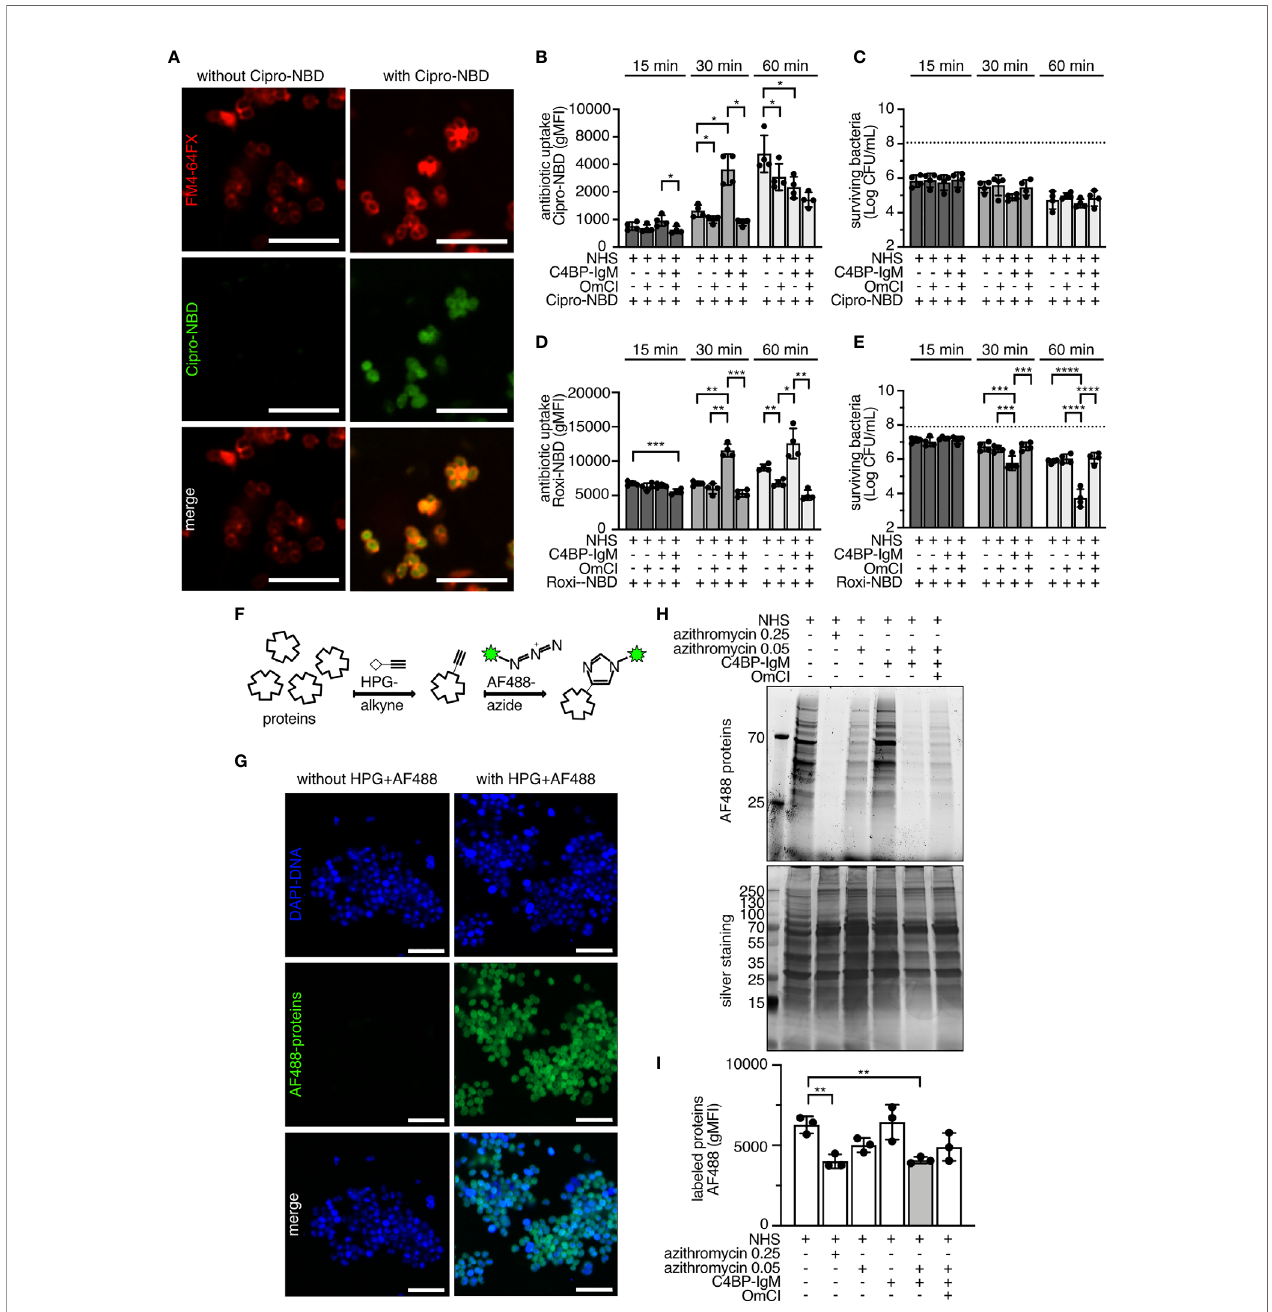
FIGURE 4 | NHS and C4BP-IgM promote in fl ux and intracellular activity of antibiotics in N. gonorrhoeae . (A) Airyscan confocal fl uorescent microscopy of live FA1090 labeled with FM4-64FX membrane dye and treated with or without 20 m M of Cipro-NBD for 60 min at 37°C. Scale bar: 5 m m. (B – E) FA1090 gonococci were incubated with 20 m M of Cipro-NBD or Roxi-NBD for 15, 30 and 60 min at 37°C in the presence of 10% NHS+/-OmCI with or without 5 (Cipro-NBD) or 2.5 m g/mL (Roxi-NBD) of C4BP-IgM. Internalized fl uorescent antibiotic is measured as fl uorescent signal (gMFI). Survival of bacteria is indicated as Log(CFU/mL) with horizontal dotted line referring to average of Log(CFU/mL) of bacteria recovered in the absence of probes. Bars display mean+/-SD with circles indicating independent repeats; n = 4. Two-way ANOVA with Tukey´s multiple comparison was performed to analyze differences among samples. *p < 0.05, **p < 0.01, ***p < 0.005, ****p < 0.0001. (F) Schematic representation of AF488-labeling of newly synthesized proteins via Click-iT chemistry. (G) Airyscan confocal fl uorescent microscopy of live FA1090 labeled with DAPI DNA dye after 4 hours incubation with 100 m g/mL HPG-alkyne at 37°C followed by 10 m M AF488-azide via